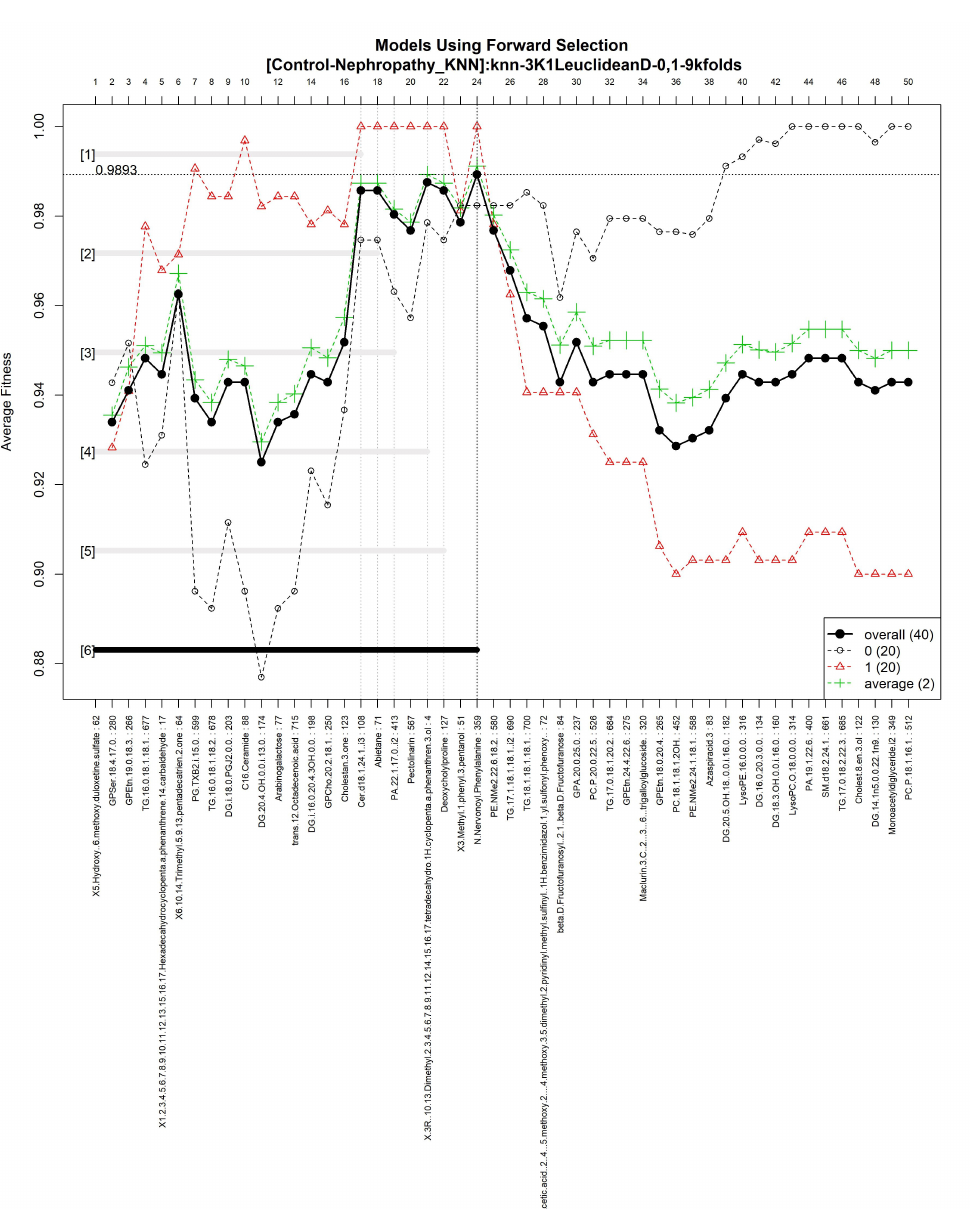
Figure 11. Models using forward selection methodology, with the Control-DN dataset. The solid black line represents the most compact and accurate models. The vertical axis shows the classification accuracy. The horizontal axis represents the ordered features, each of which corresponds to a